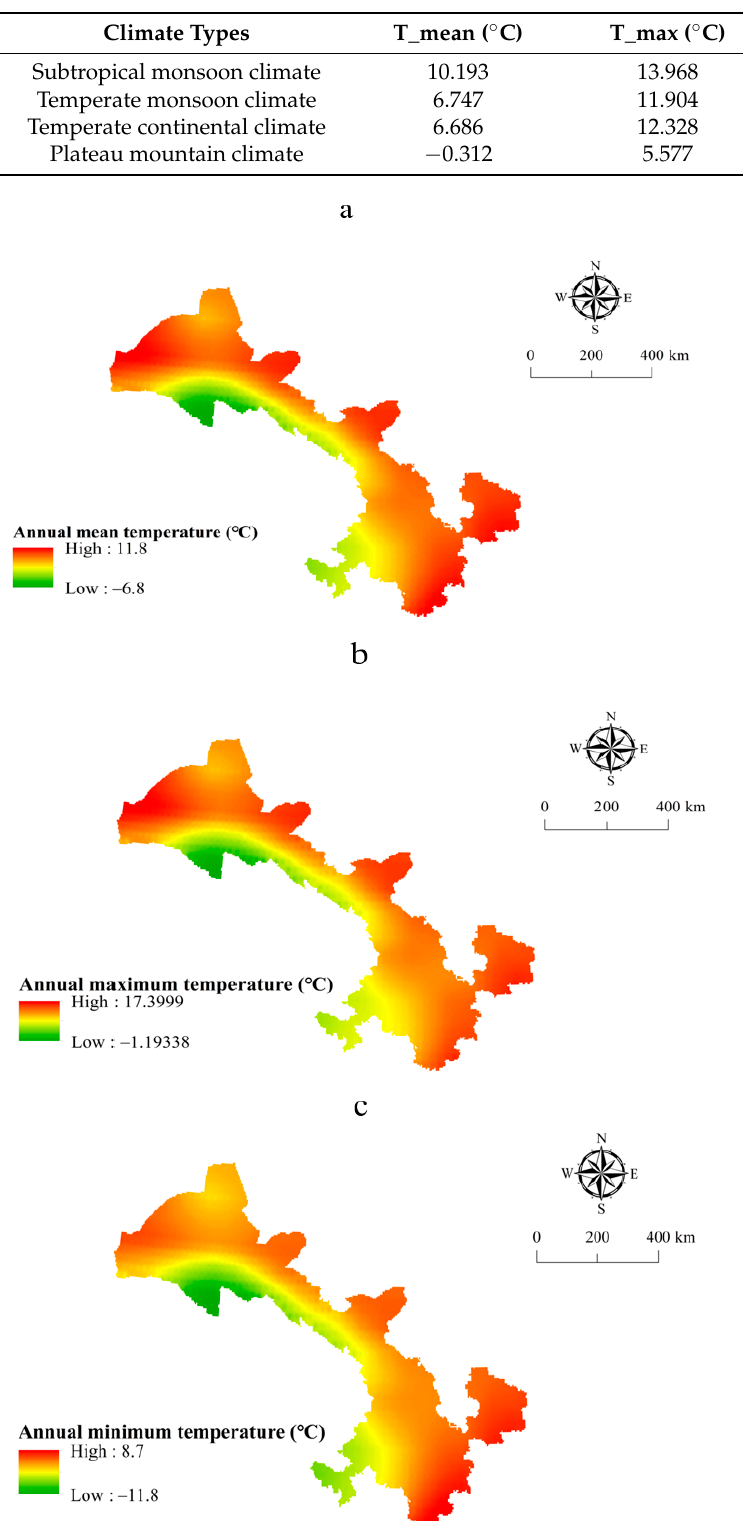
Figure 2. Distribution of ERA-Interim temperatures in Gansu Province. ( a ) Mean temperature. ( b ) Maximum temperature. ( c ) Minimum temperature. ( b ) Maximum temperature. ( c ) Minimum